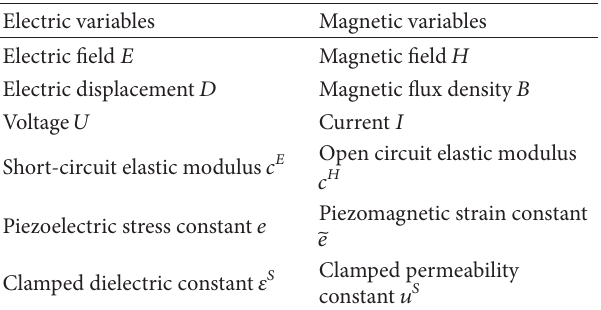
Table 2: The analogous relationships between electric and magnetic